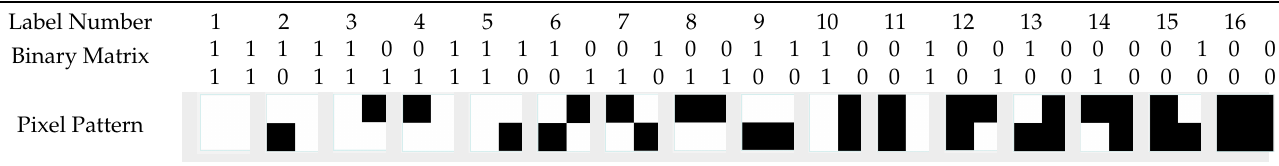
Table 1. Pixel distributions within one cluster.